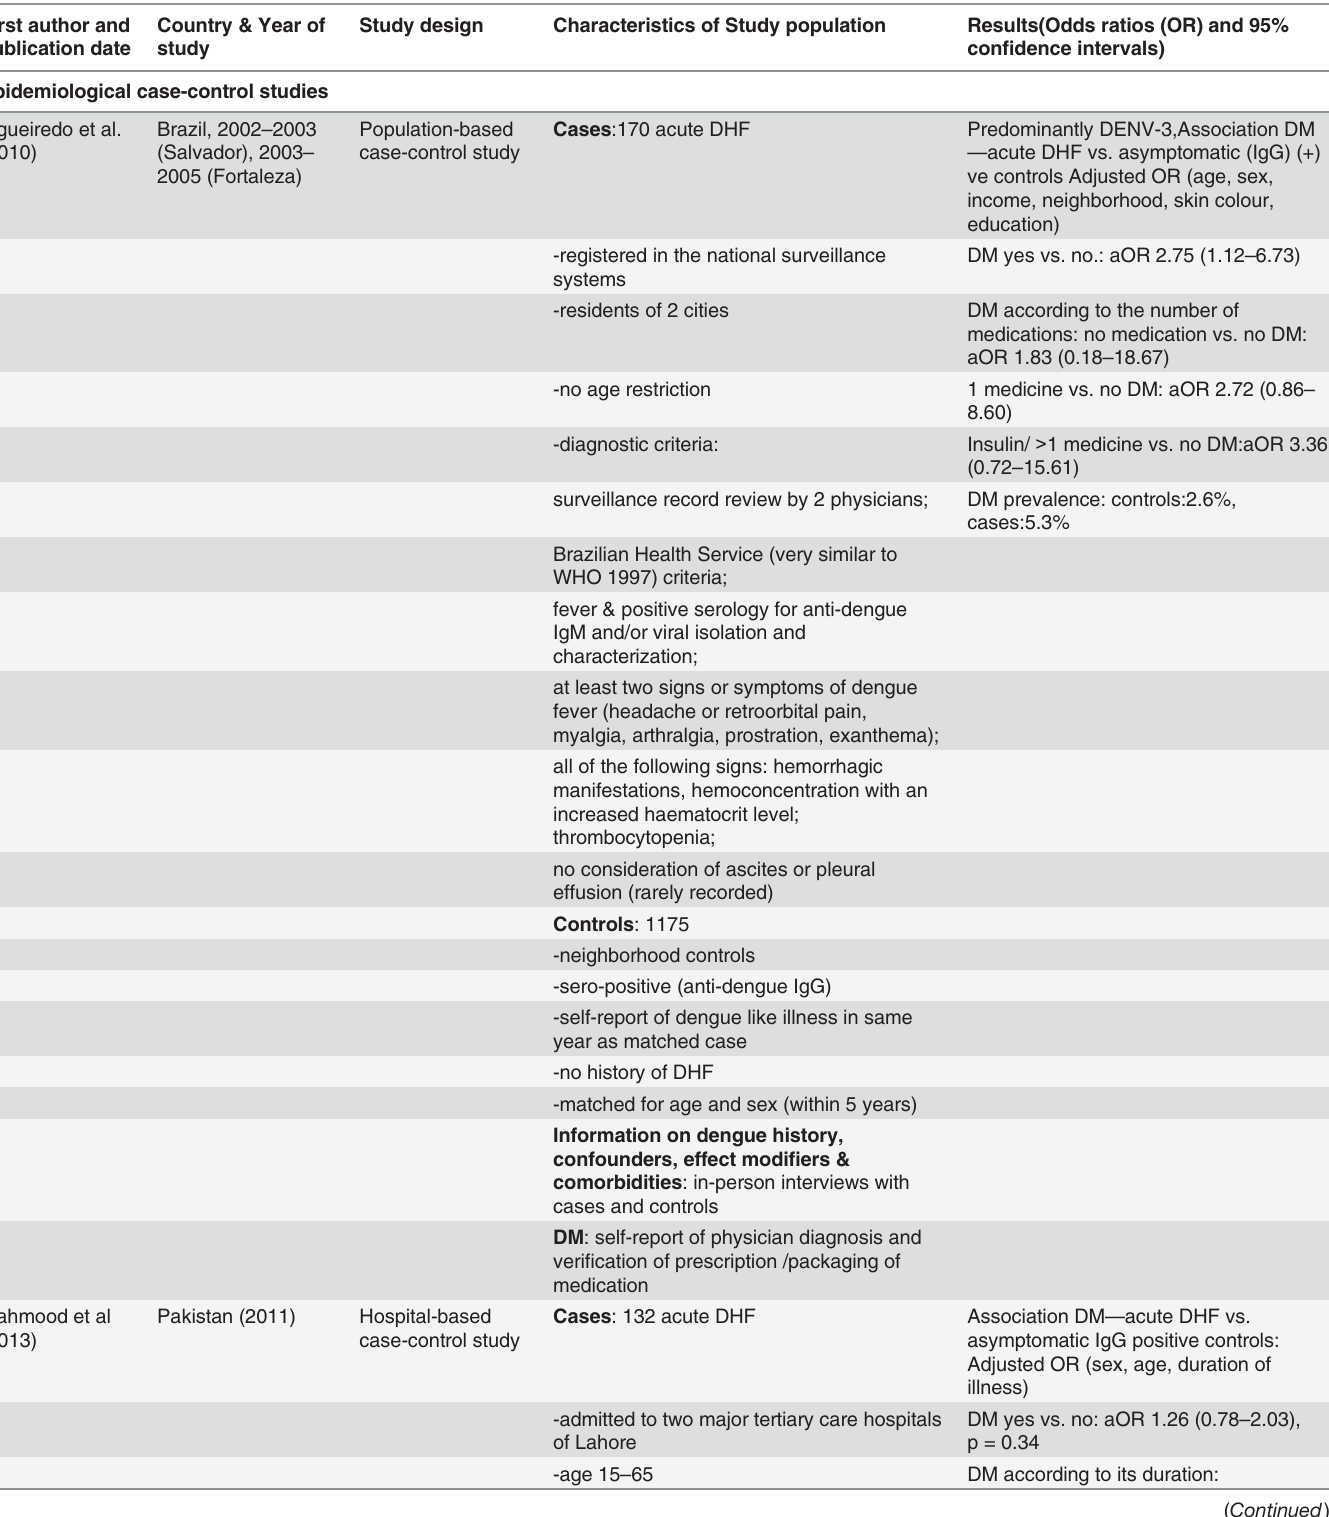
Table 1. Summary of case-control studies and case